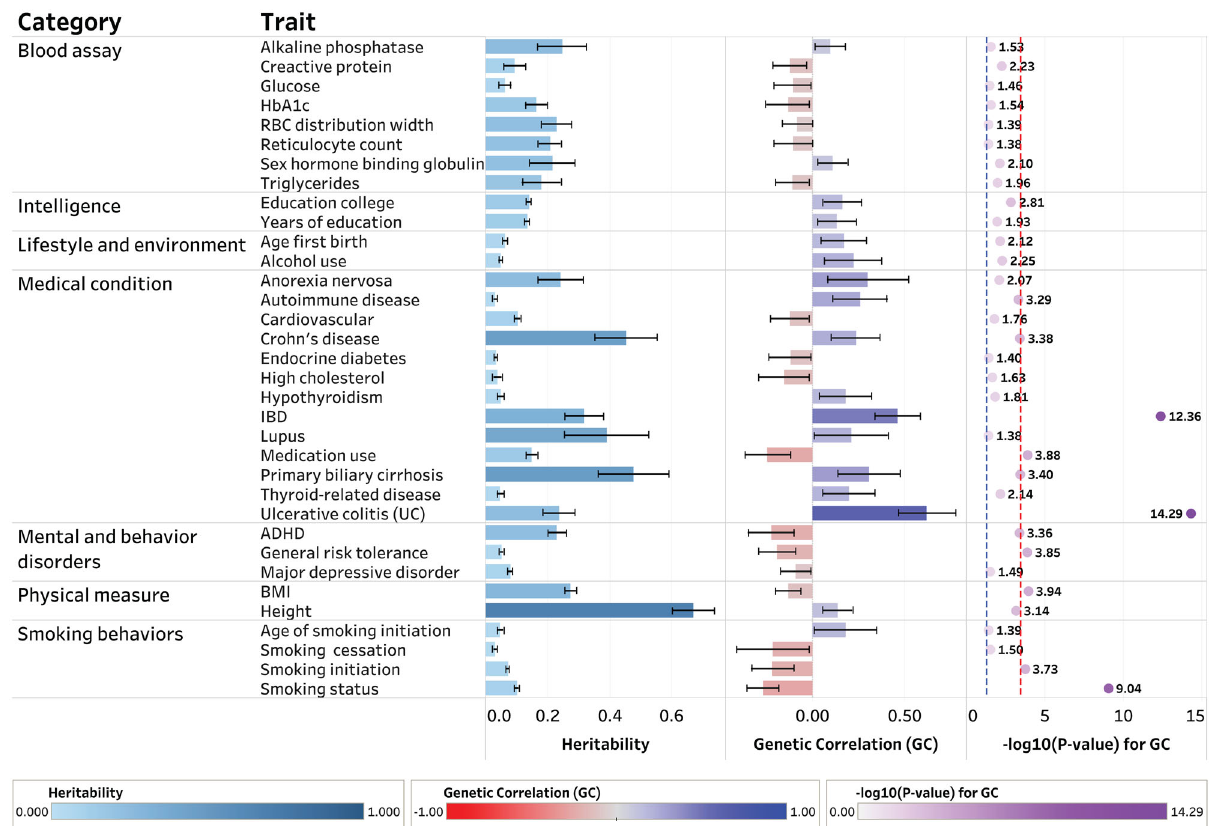
Fig. 2 | The shared heritability and genetic correlation of PSC among clinical and epidemiological traits. The dotted lines in blue and red indicate nominally and Bonferroni-corrected signi fi cant levels of (cid:1) log 10 0 : 05 ð Þ =1 : 30 and (cid:1) (cid:3) : 73×10 (cid:1) 4 (cid:1) log =3 : 43, respectively. The error bar represents 95% con fi dence 10 3 interval for the estimate of SNP-based heritability and pairwise genetic correlation